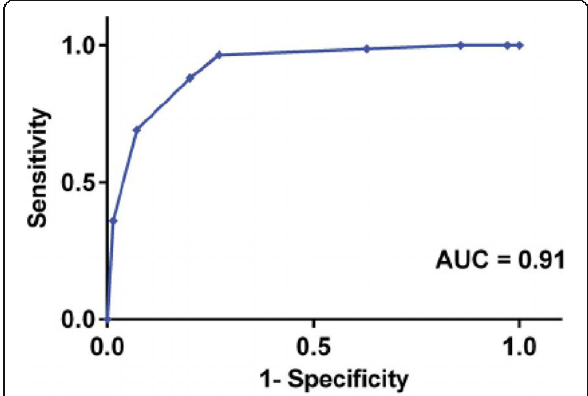
Fig. 2 ROC curve showing the correlation between DWI and pathological